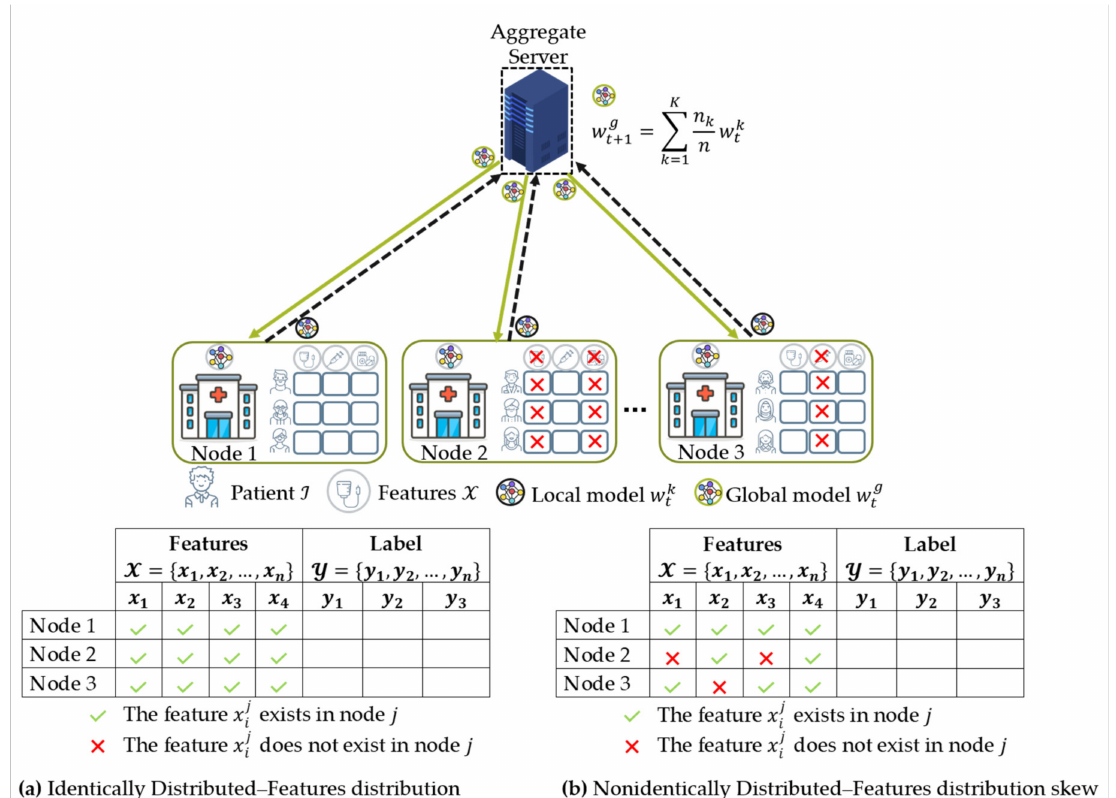
Figure 11. Non-IID from feature distribution skew characteristic. ( a ) IID case: the distribution of features X exists in all nodes; ( b ) non-IID case: the distribution of features X varies between each node. For instance, node two does not have the features x 1 and x 3 while the other nodes have those